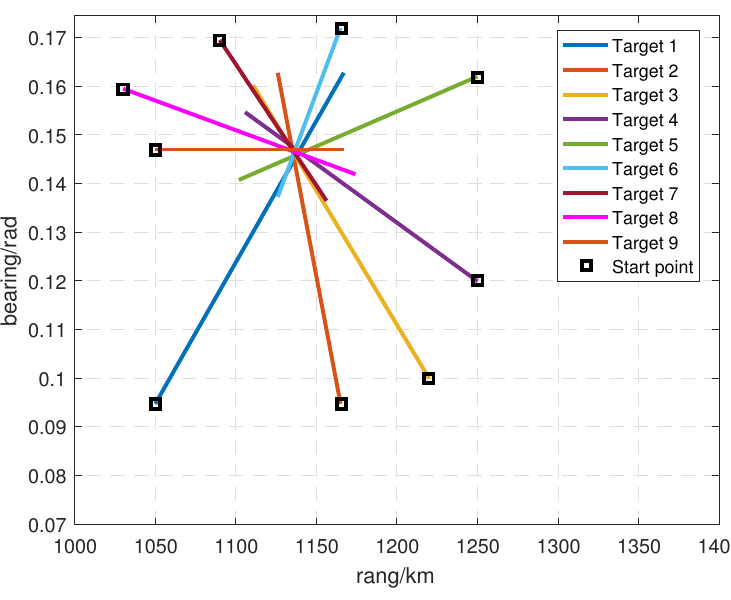
Figure 11. Simulation Scenario